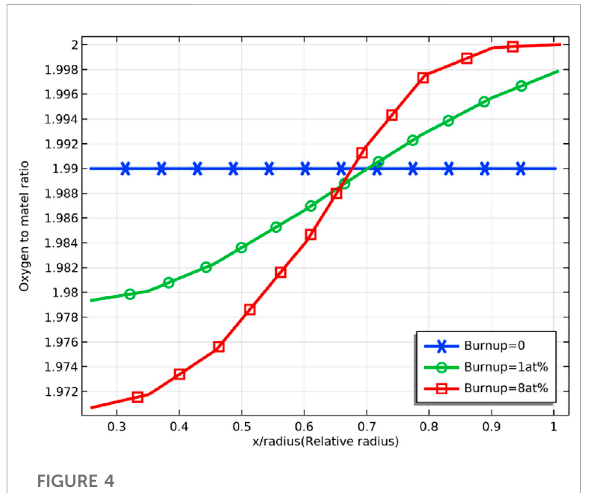
FIGURE 4 Radial distribution of oxygen/metal ratio at 0, 1 at% and 8 at% fuel burnup (with initial oxygen/metal ratio of 1.99)